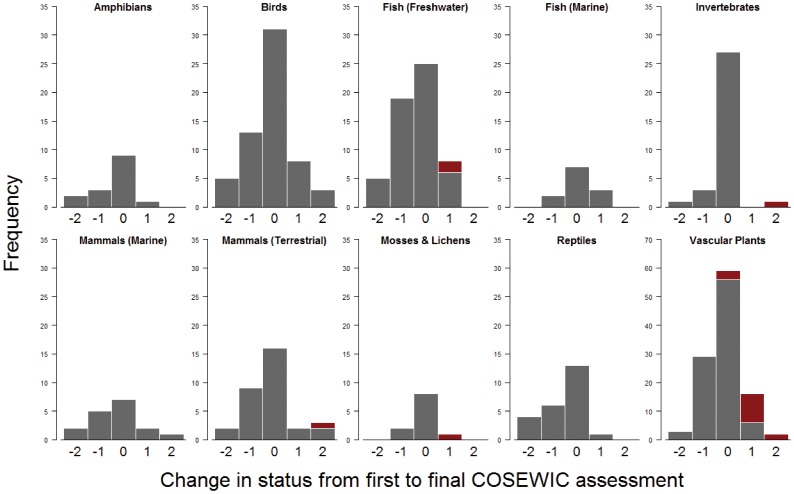
Frequencies of occurrence of change in COSEWIC assessed status for each taxonomic group.Positive numbers indicate improvement (e.g. a transition from endangered to threatened would be +1, while endangered to special concern would be +2), negative numbers indicate deterioration, and zero indicates no change across assessments. Red bars indicate apparent recoveries due to increased sampling efforts. Note that the y-axis for vascular plants is scaled differently from other taxonomic groups.